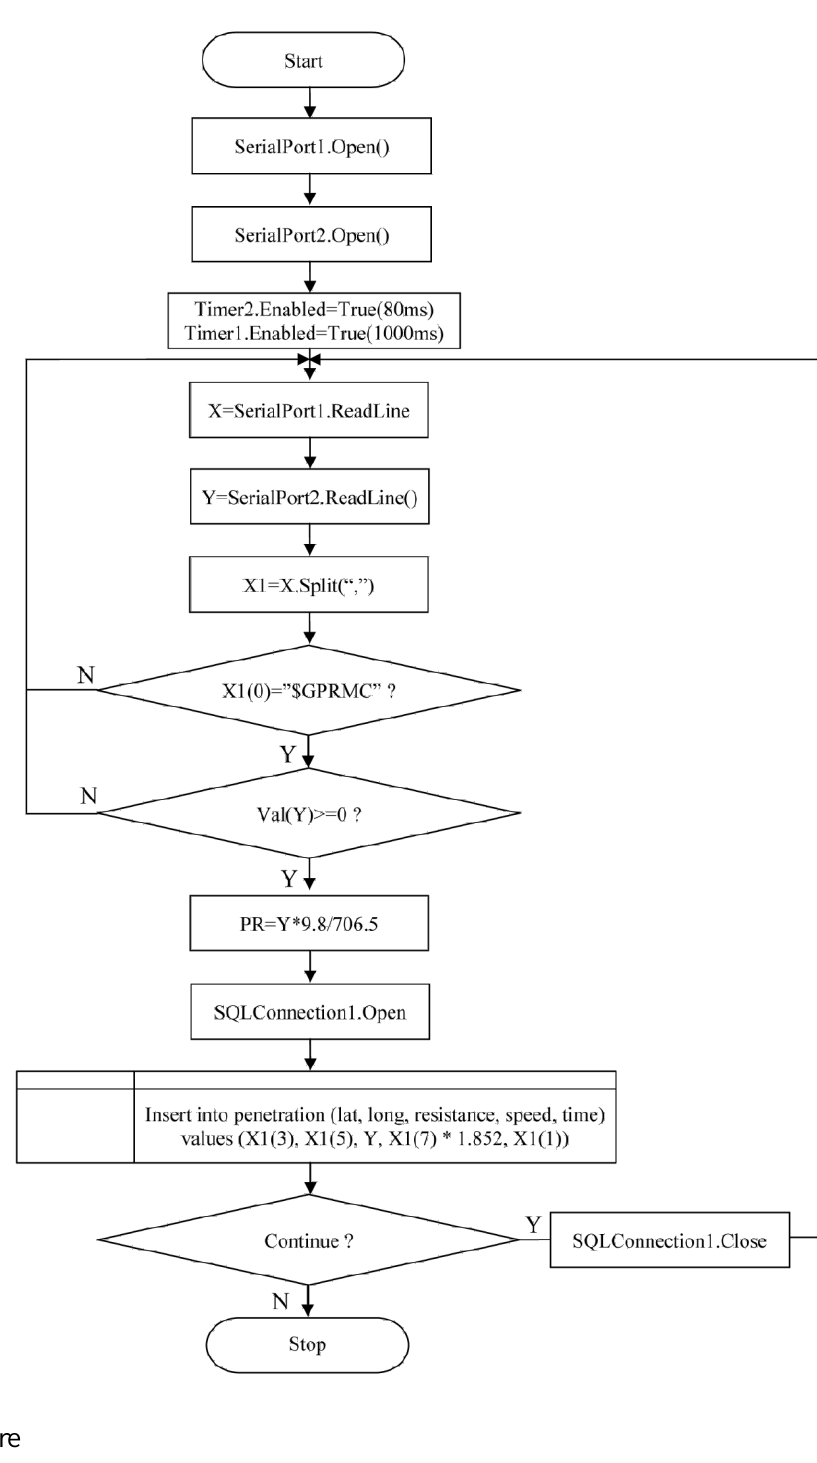
Figure 5. Flow chart of the